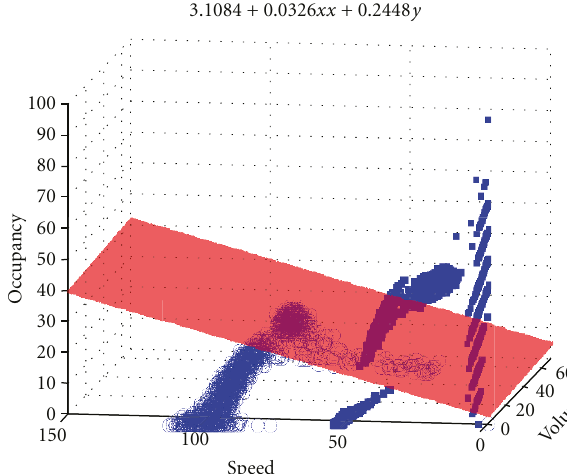
Figure 11: Congested Tra ffi c Plane for C-SVM of OAAM.